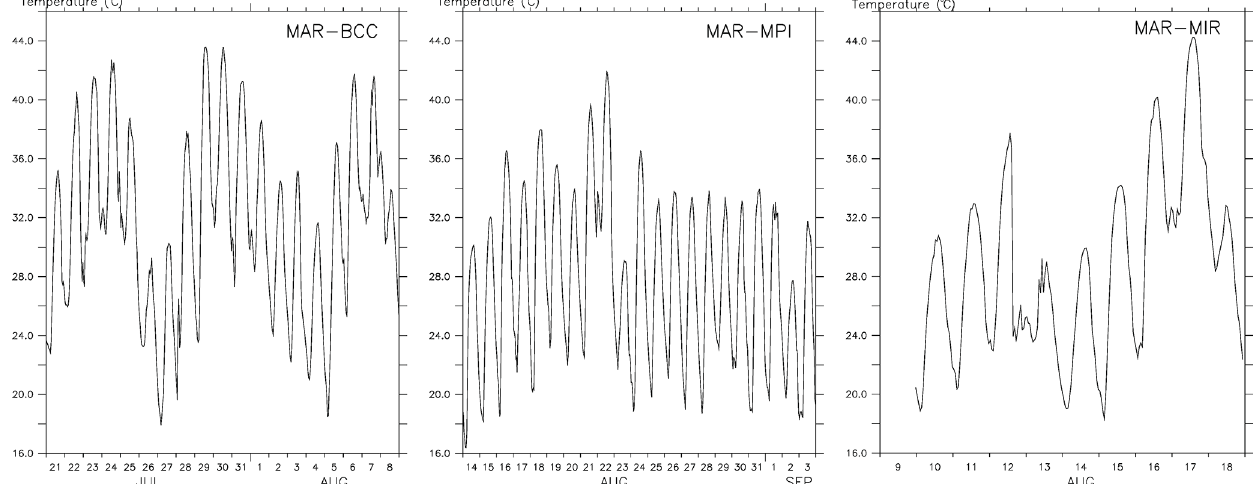
Figure A2. Temperature during warmest heatwave events for Liège city simulated by MAR-BCC (i.e. MAR forced by BCC-CSM2-MR), MAR-MPI (i.e. MAR forced by MPI-ESM.1.2), and MAR-MIR (i.e. MAR forced by MIROC6), with the scenario SSP5-8.5 for the pe- riod 2085–2100. These data are, respectively, extracted from these files: Liège-City_HWE-HT_2085-2100_ssp585_MAR-BCC.csv,